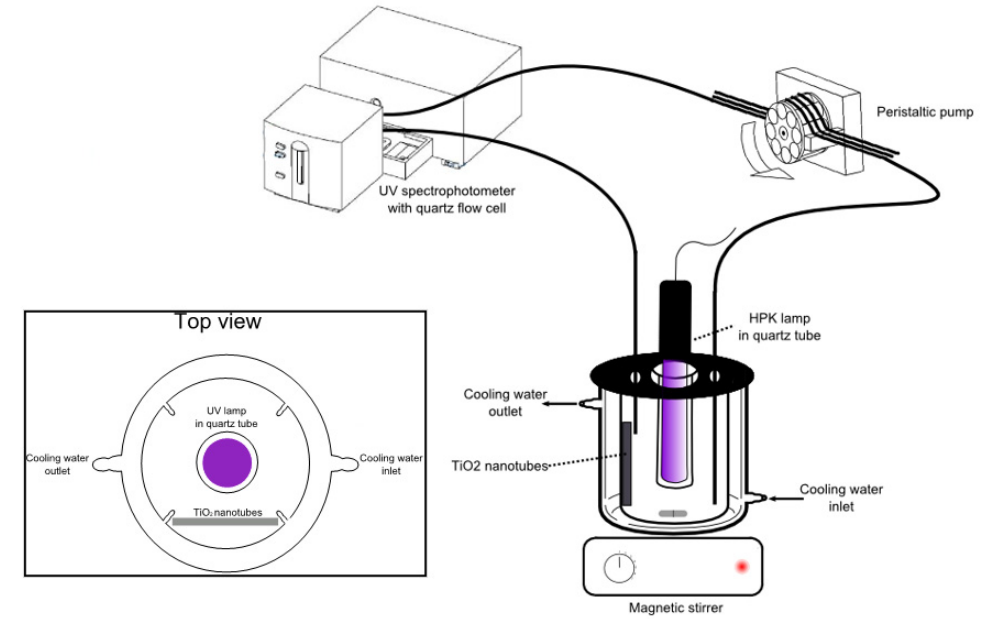
Figure 7. Experimental setup.